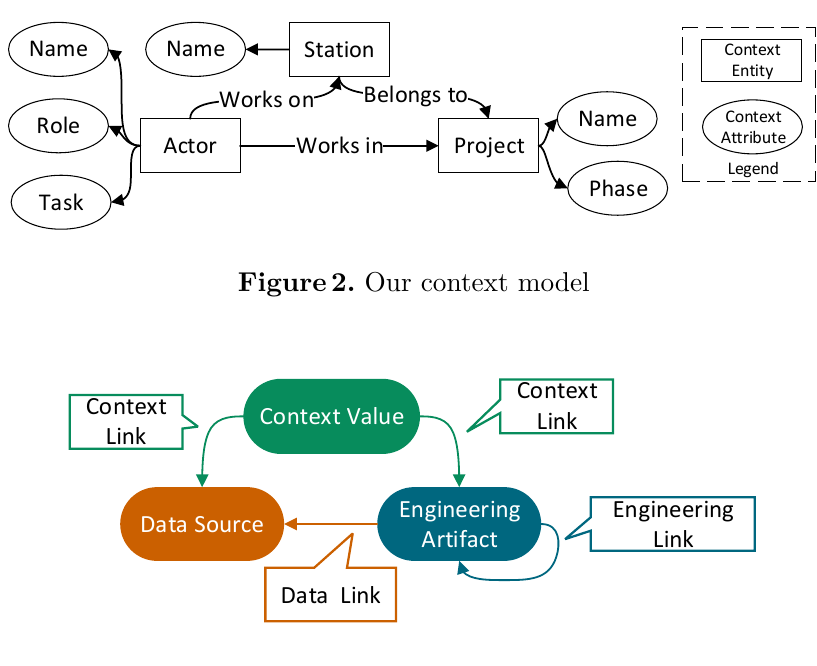
Figure 3. Context-aware engineering model